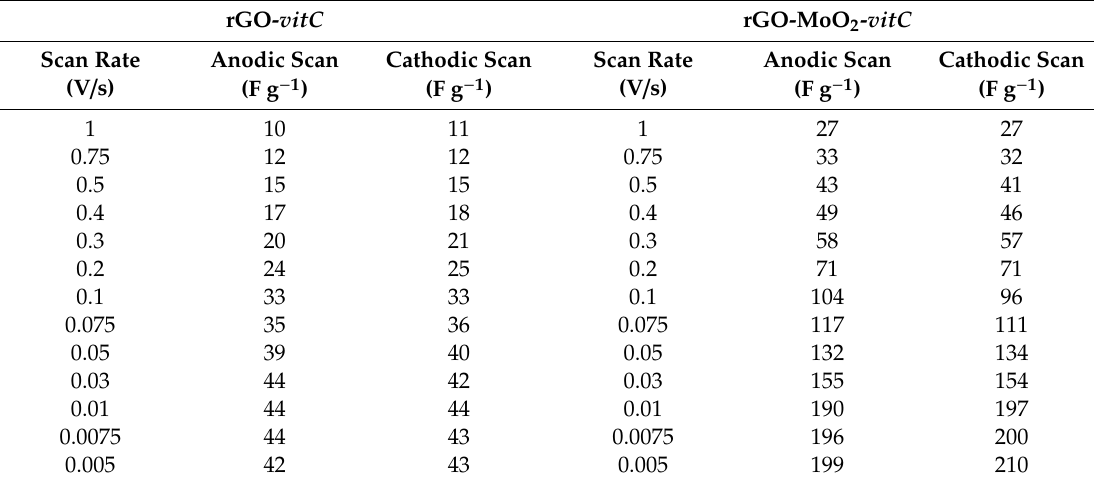
Table 2. Capacitance estimated during the anodic and cathodic scans at di ff erent scan rates recorded on rGO- vitC and rGO-MoO 2 - vitC. rGO- vitC rGO-MoO 2 - vitC Anodic Scan Cathodic Scan Scan Rate Anodic